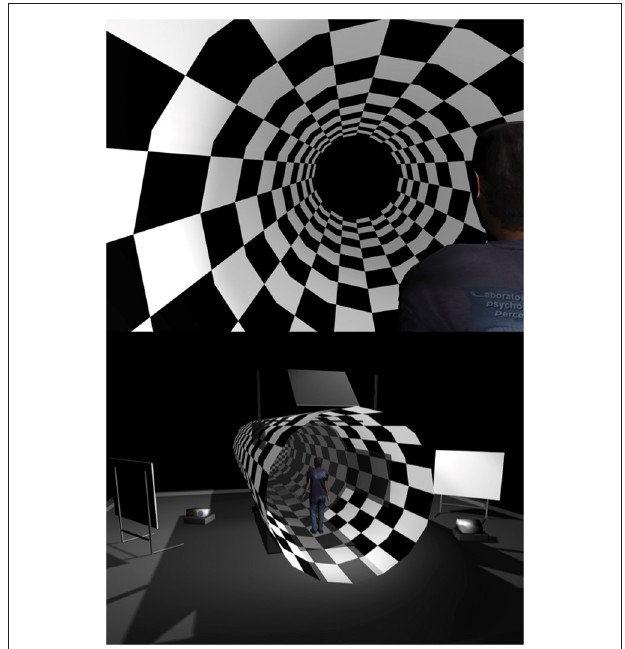
FIGURE 1 | The Virtual Tunnel